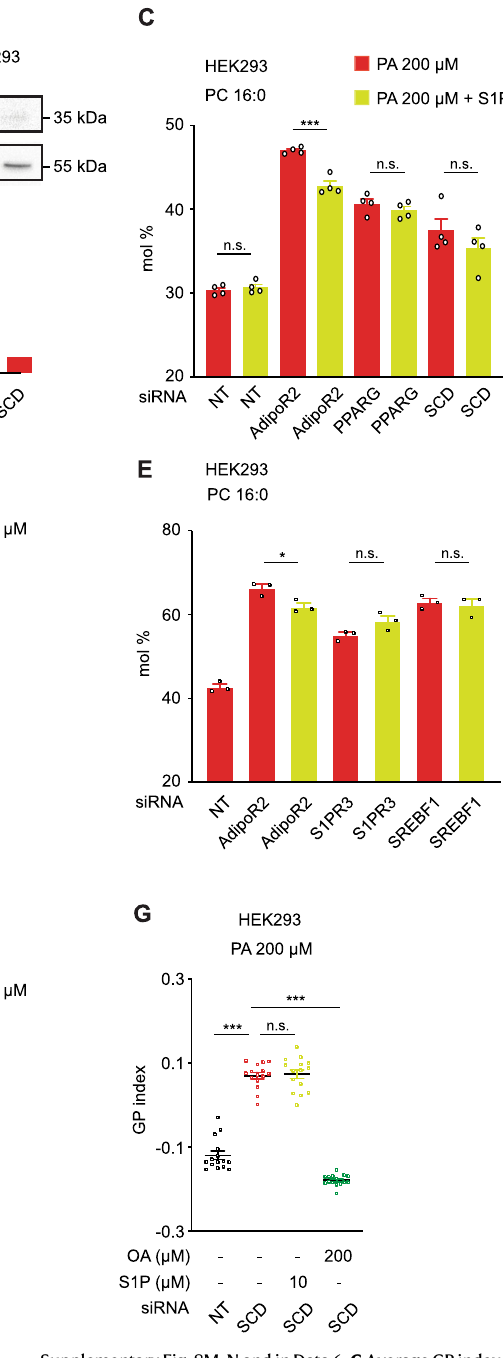
SupplementaryFig.8M,NandinData6. G AverageGPindexfromseveralimagesof NT and SCD siRNA HEK293 cells treated with vehicle and PA 200 µ M ± S1P 10 µ M and ± OA 200 µ M. n =15 separate images analyzed for each condition. Data are represented as mean±SEM. t -tests (two sided and assuming normality) were used to identify signi fi cant differences between treatments. * p <0.05, ** p <0.01, *** p <0.001. See also Supplementary Fig. 8 and Supplementary Data 5 – 7. Source data are provided as a Source Data fi